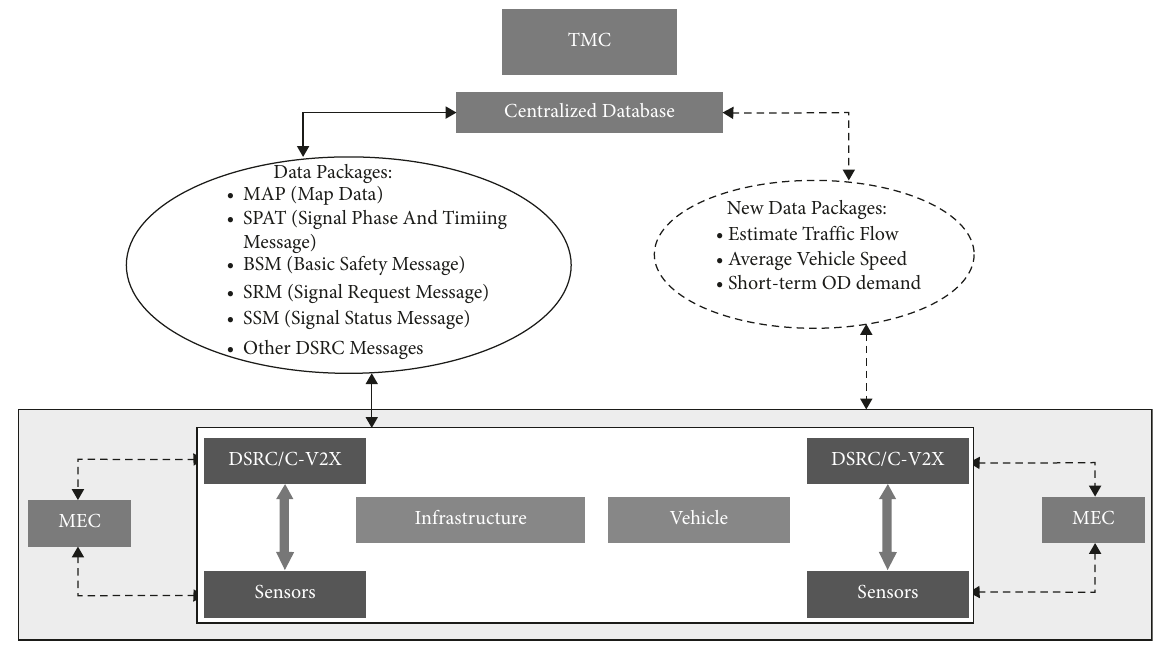
Figure 6: CV environment with/without